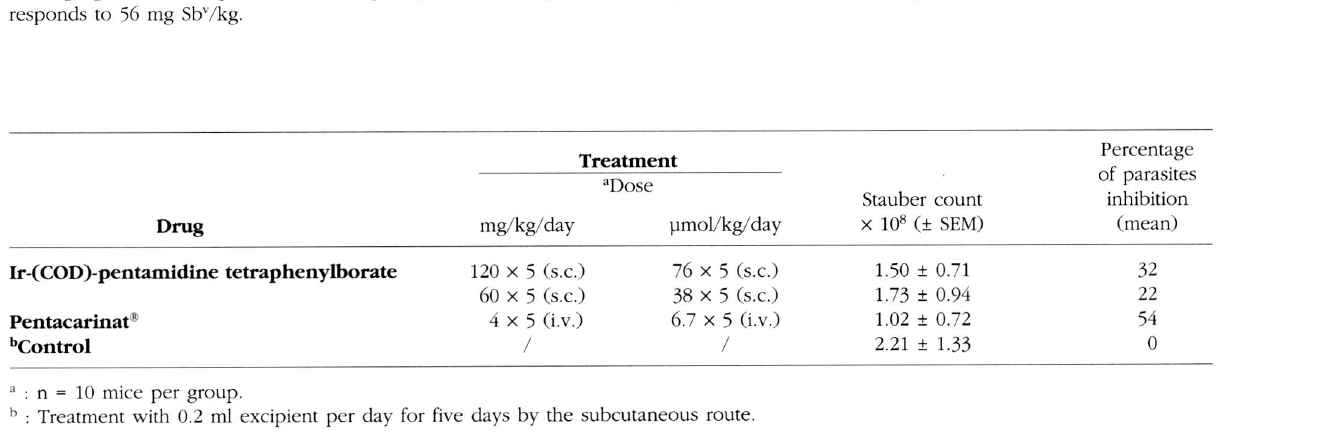
Table II. - Effect of Ir-(COD)-pentamidine tetraphenylborate on the L. major CRY. 26/BALB/c mouse model compared with reference drugs. Parasite, 2000, 7,